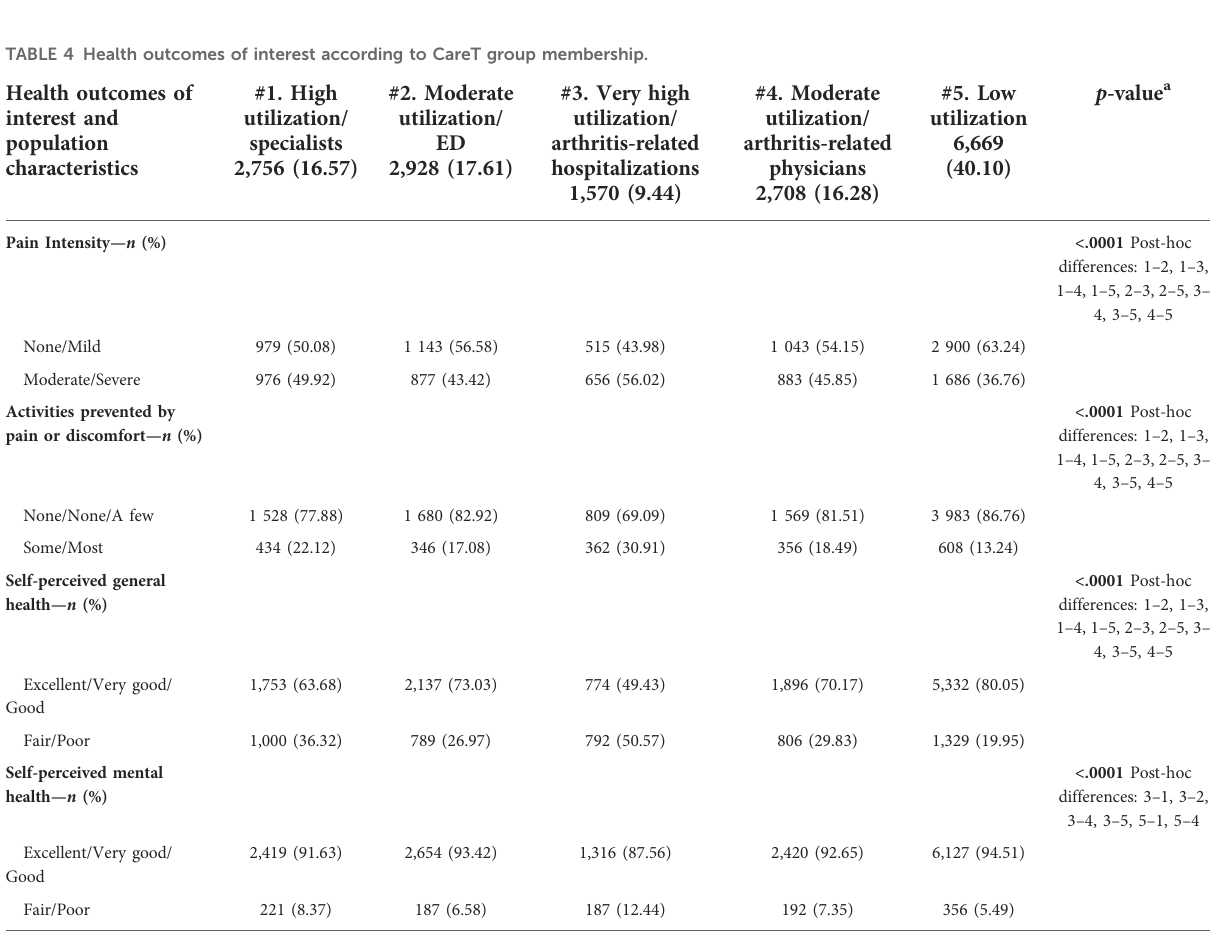
Table 6 provides the main fi ndings of the multivariable model used to evaluate the association between CareT group membership and self-perceived general health.